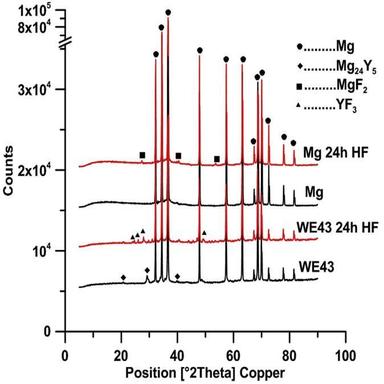
XRD patterns of composite materials.